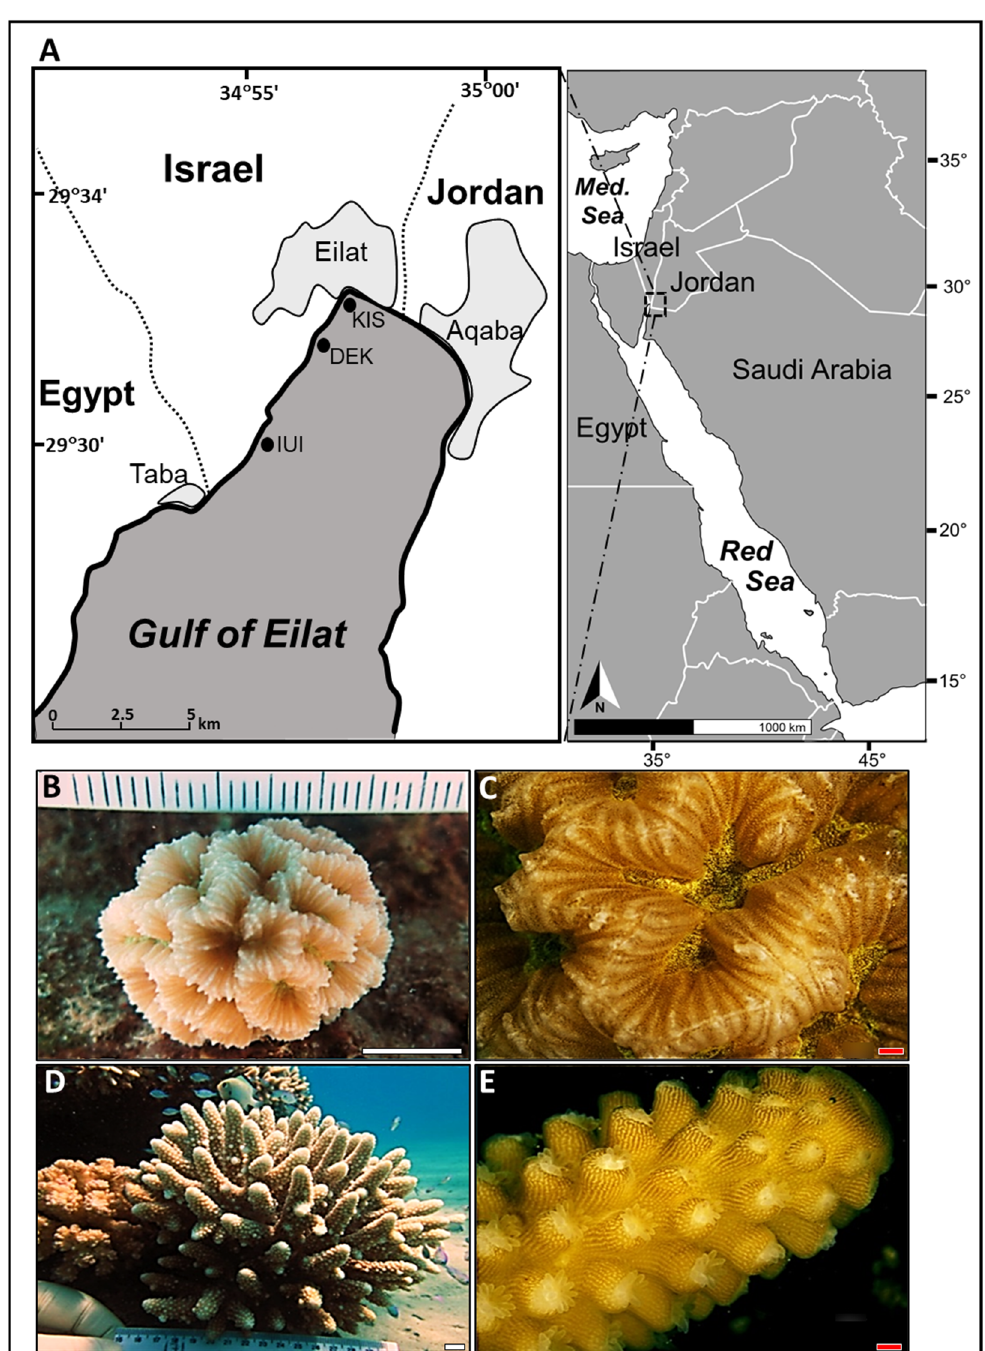
Figure 1. ( A ) Sampling sites at the Gulf of Eilat’s reef, Israel: Kisoski beach (KIS), Dekel beach (DEK) and the Interuniversity Institute (IUI). ( B – E ) Photographs of coral vouchers. The in situ and the close-up photographs of Platygyra carnosa Veron, 2000 ( B , C ), and Acropora samoensis (Brook, 1891) ( D , E ). White bars—1.0 cm ( B , C ), red bars—1.0 mm ( C , E ).